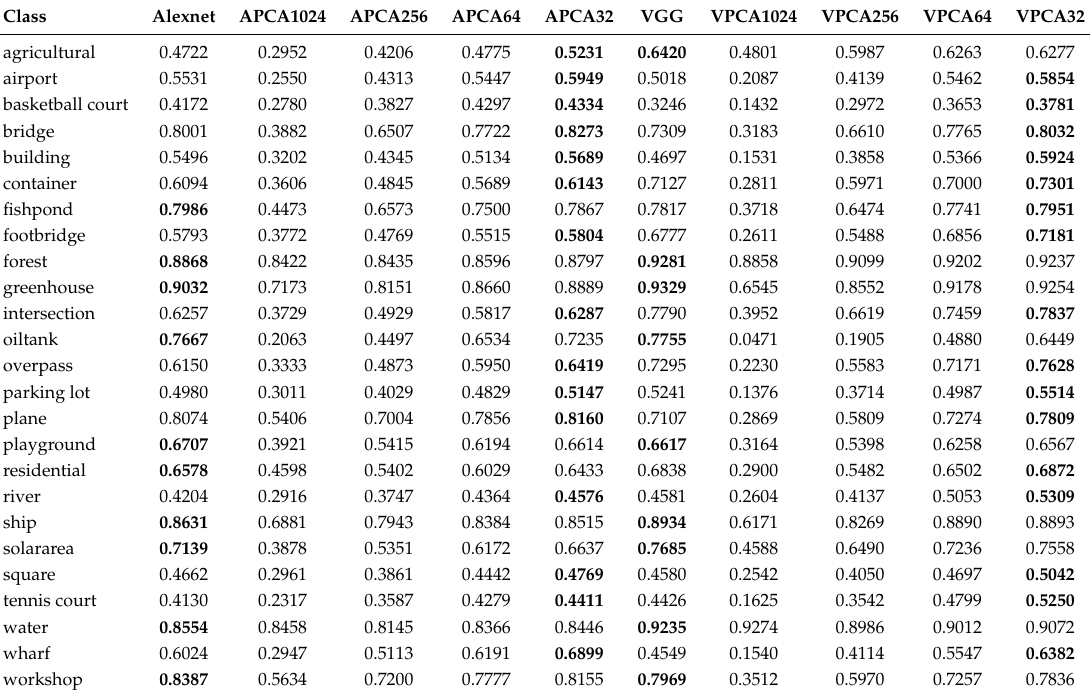
Table 10. P@150 values obtained using the DPCA method.